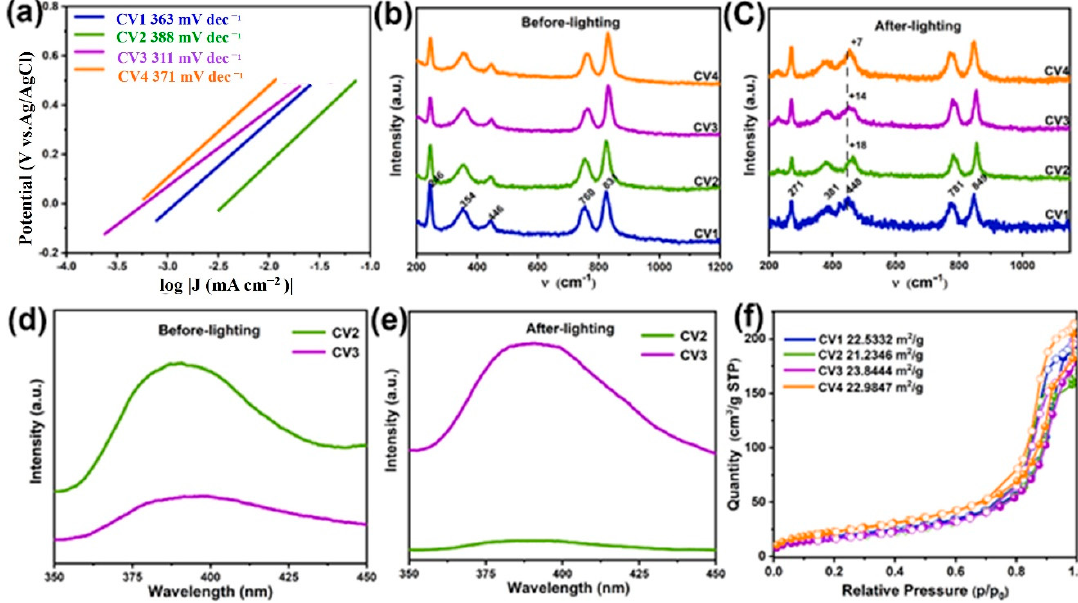
Figure 8. ( a ) LSV curves of CV1-CV4, ( b , c ) comparison of the Raman spectra, ( d , e ) photoluminescence spectra of the CeVO 4 catalysts before and after the photocatalytic reaction and ( f )BET curves of CV1-CV4. Table 2. Raman peaks and various groups. Raman peaks Group Raman vibrations modes